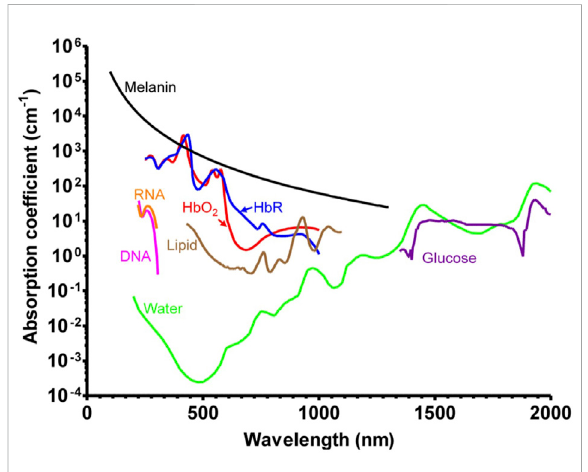
FIGURE 2 Absorption spectra of major endogenous contrast agents in biological tissue [reproduced from (Wang and Hu., 2012) with permission from The American Association for the Advancement of